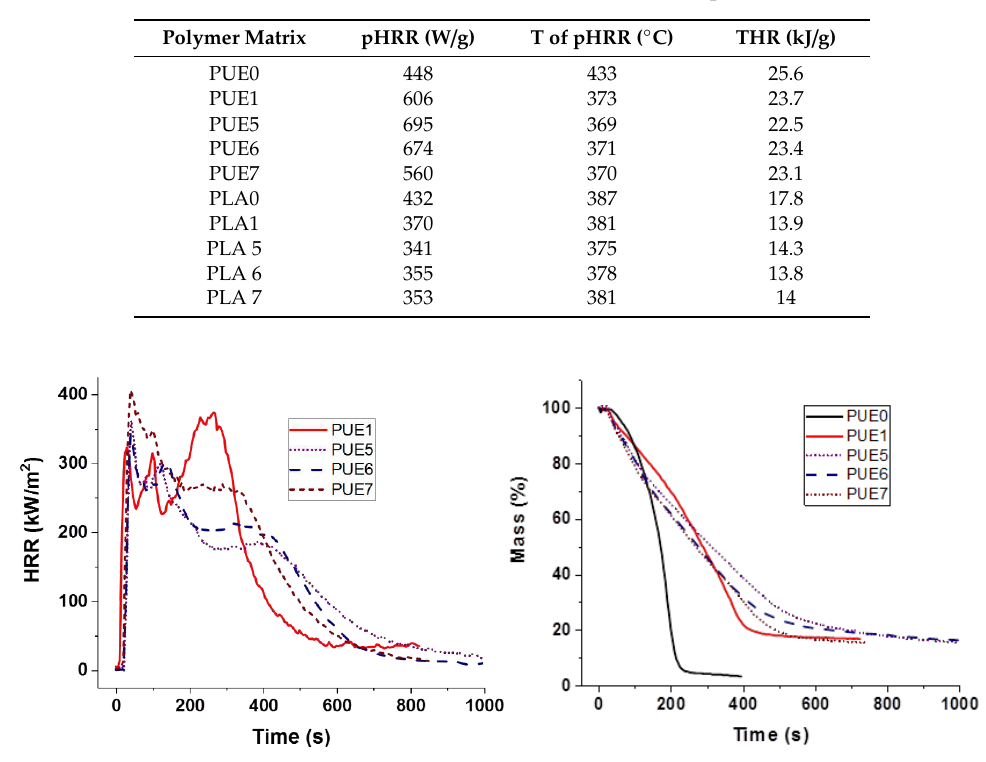
significantly the fire retardancy. pHRR is lower for APP/lignin except for the highest lignin content. Evolutions of THR, MARHE and experimental residues are in accordance with pHRR values, evidencing a synergistic effect between APP and lignin up to 5 wt% lignin in the composition (Table 7). The strong char promoter activity of lignin is highlighted for PLA5 and PLA6. The important reactivity between the components leads to a dramatic reduction in time to ignition.